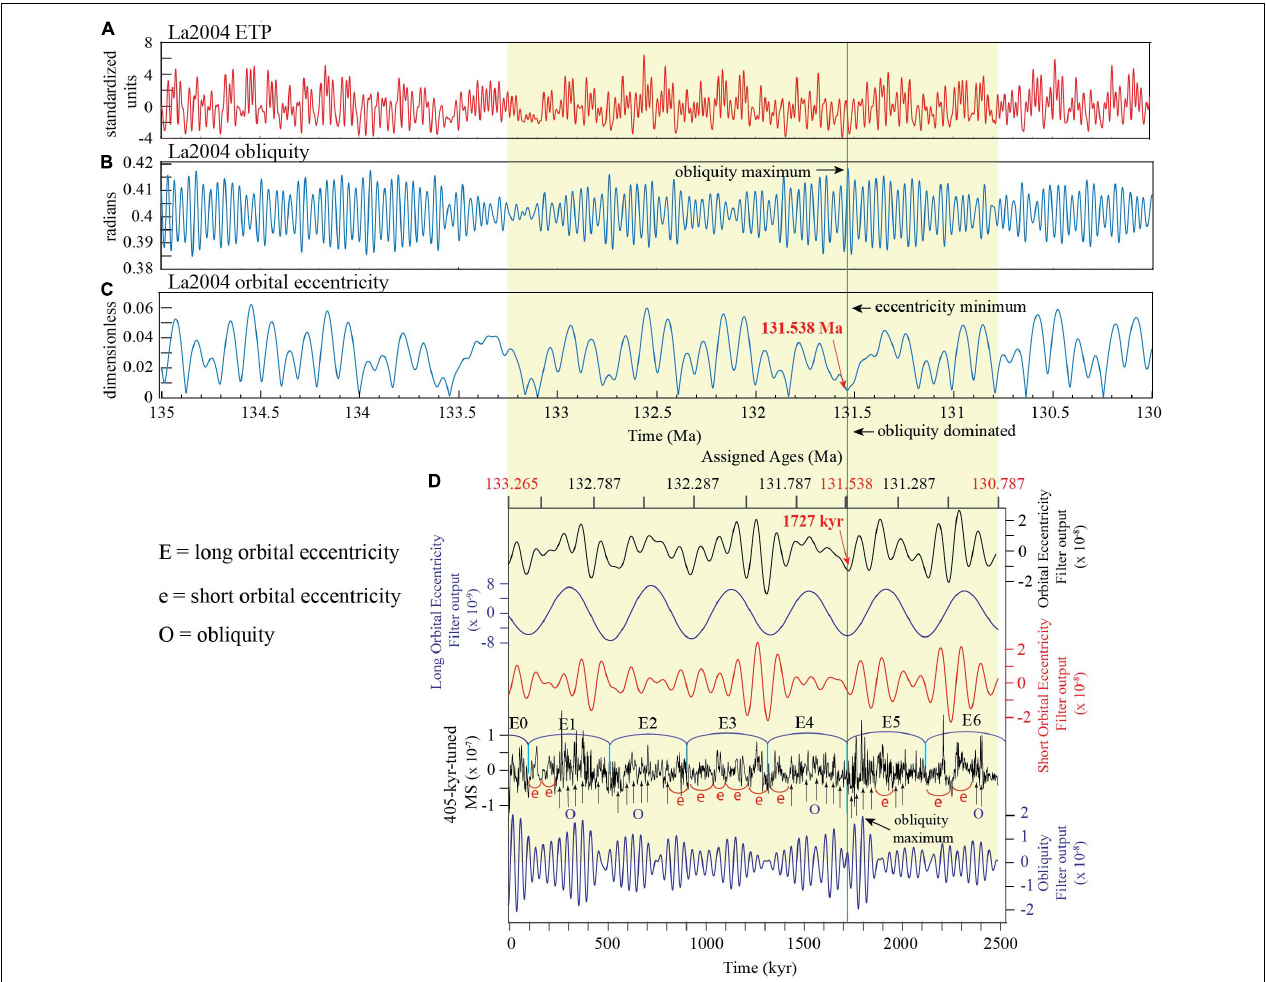
FIGURE 8 | Proposed correlation between DBG MS cyclostratigraphy and the La2004 astronomical solution from 135 to 130 Ma. The yellow shading indicates the proposed correlation interval, from 133.265 to 130.787 Ma; the green vertical line indicates a confluence of minimum orbital eccentricity and maximum obliquity in the La2004 solution. (A) La2004 ETP computed by standardizing and adding together the orbital eccentricity, obliquity and precession index solutions, producing a model with equal variance contributions from all three astronomical parameters. (B) The La2004 obliquity variation. (C) The La2004 orbital eccentricity solution. (D) The 405-kyr-tuned DBG MS time series, from the top: orbital eccentricity bandpass-filtered time series; 405-kyr (long orbital eccentricity) bandpass-filtered time series (E0-E6 are as in Figure 2 ); ∼ 100 kyr (short orbital eccentricity) bandpass-filtered time series; the Taner-highpass-filtered time series (see Preprocessing); and ∼ 37-kyr (obliquity) bandpass-filtered time